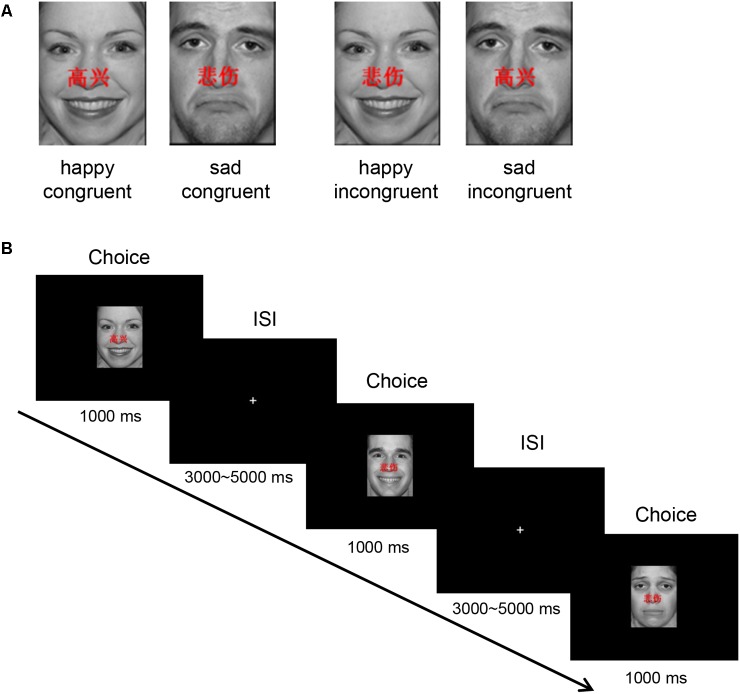
Experimental protocol. (A) An example of stimuli materials for each condition. (B) Example timelines used in the face–word Stroop task. Participants needed to complete the identification of facial affect with happy or sad expressions that had either “” (which means “happy”) or “” (which means “sad”) word written across them.